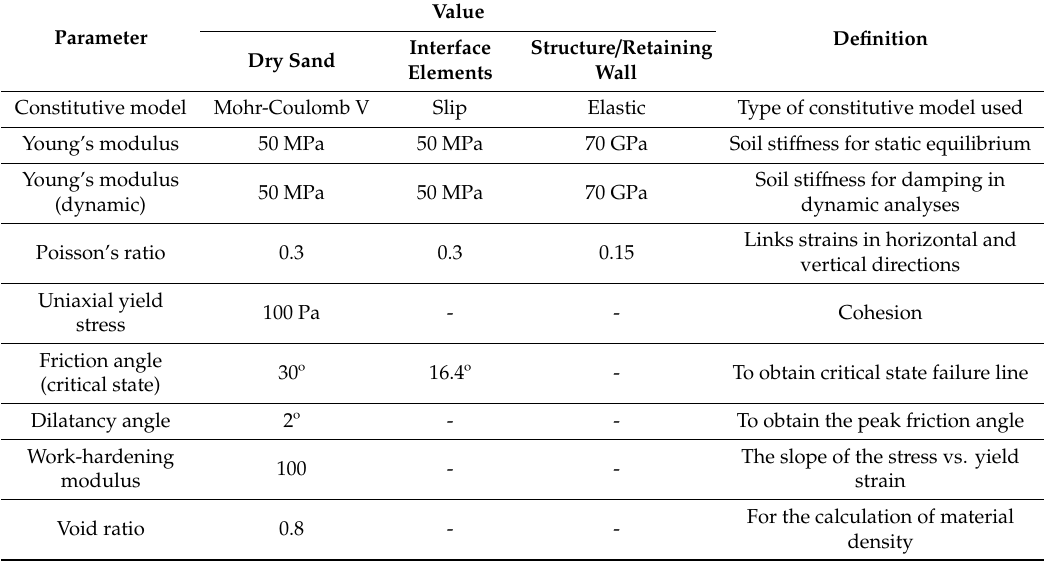
Table 2. Details of constitutive